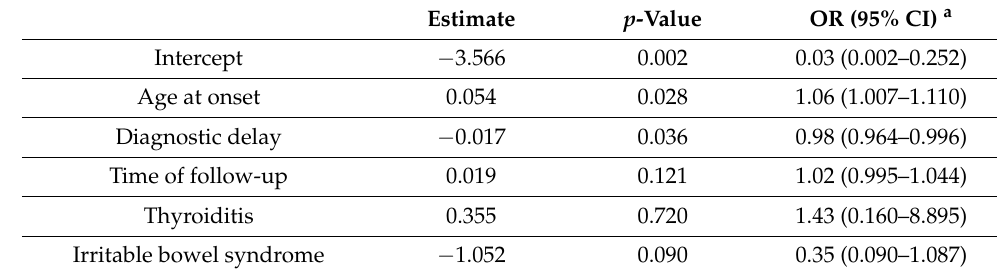
Table 2. Multivariate analysis of factors associated with recovery/significant